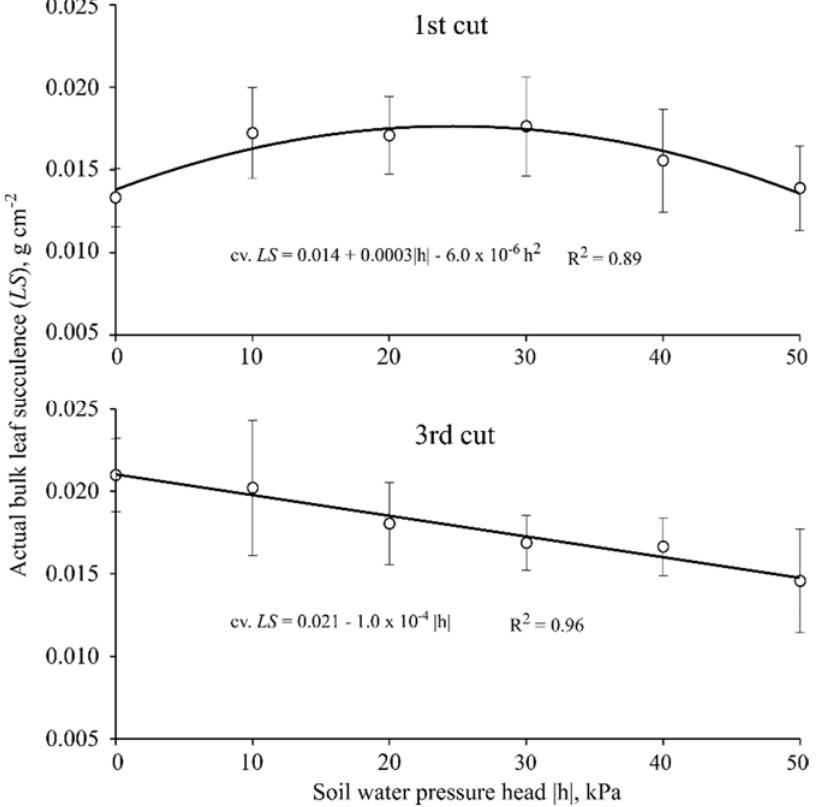
Figure 4. Regression models relating soil water pressure head to bulk leaf succulence of Brachiaria brizantha cultivars for the first and third cutting periods (40 and 70 DAE). Error bars correspond to the standard deviation of the four replicas.